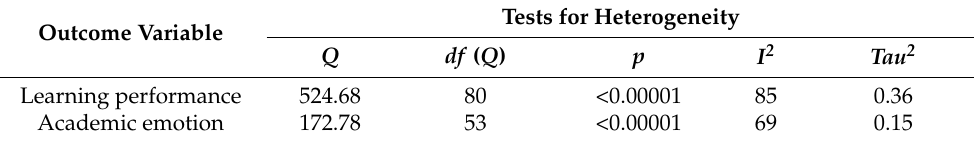
Table 4. Heterogeneity test of effect